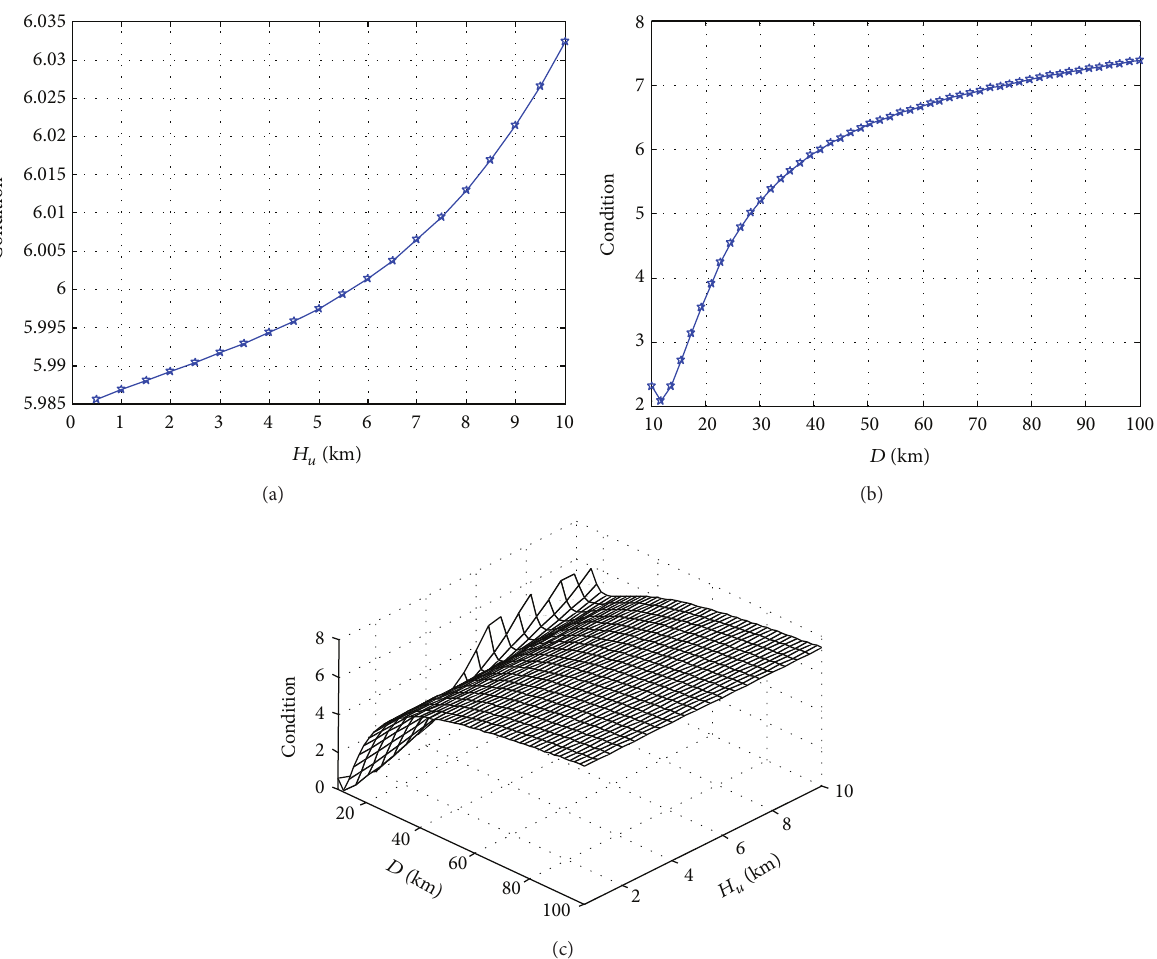
Figure 6: Influence of flight distance on the condition number of channel matrix. (a) Flight height; (b) flight distance; (c) three-dimensional